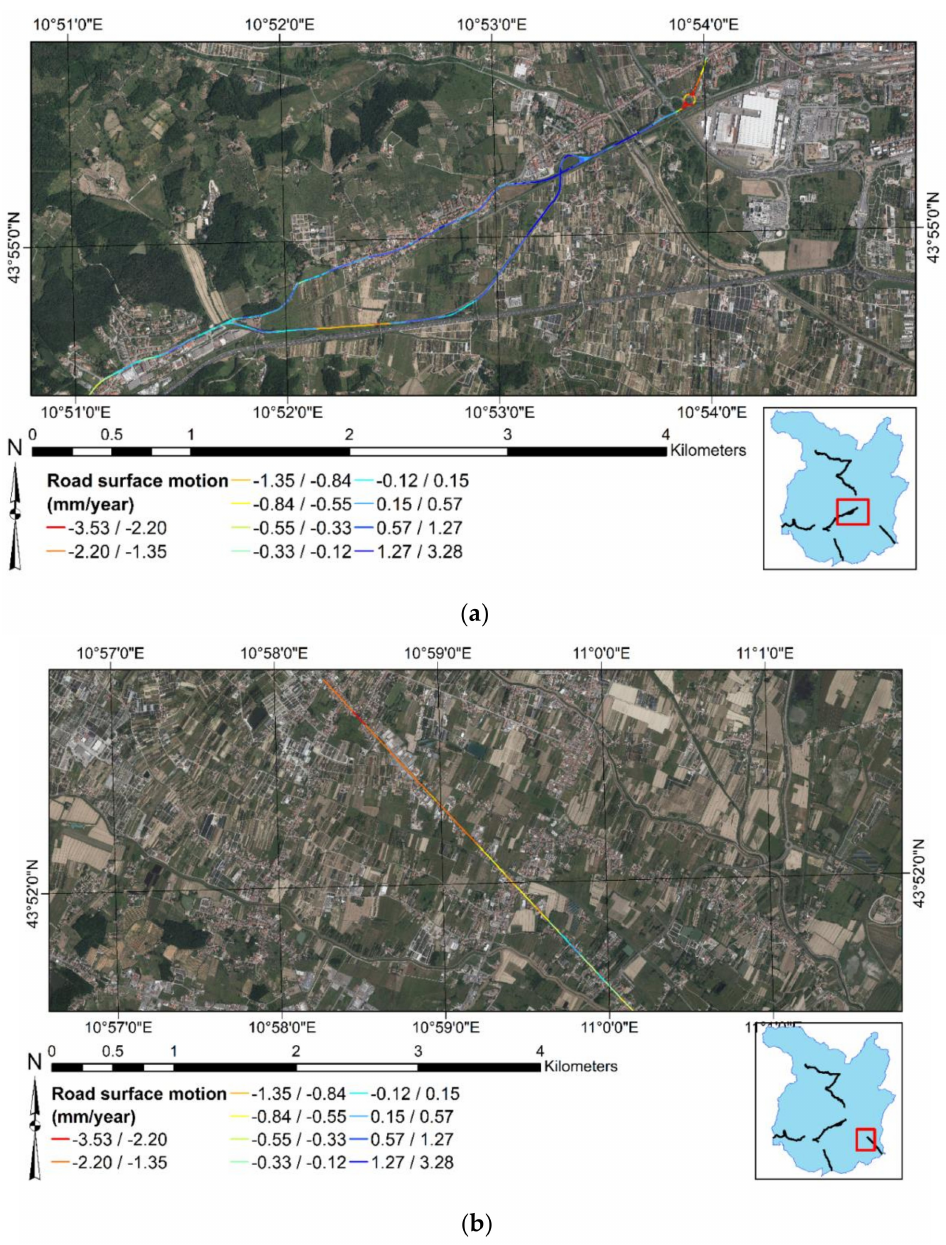
Figure 8. Road surface deformation estimated by MLAs: ( a ) test site 1 and test site 2. ( b ) Test site 3. The present figure has been adapted from Fiorentini et al.